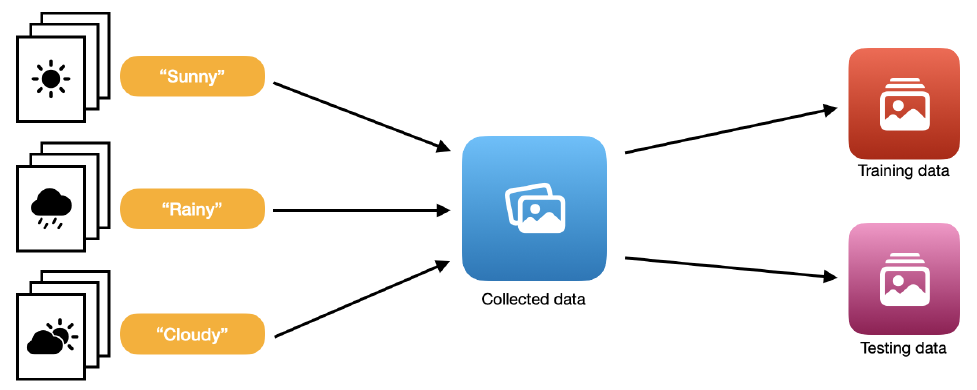
Figure 3. The preparation of datasets for Create ML (image data).